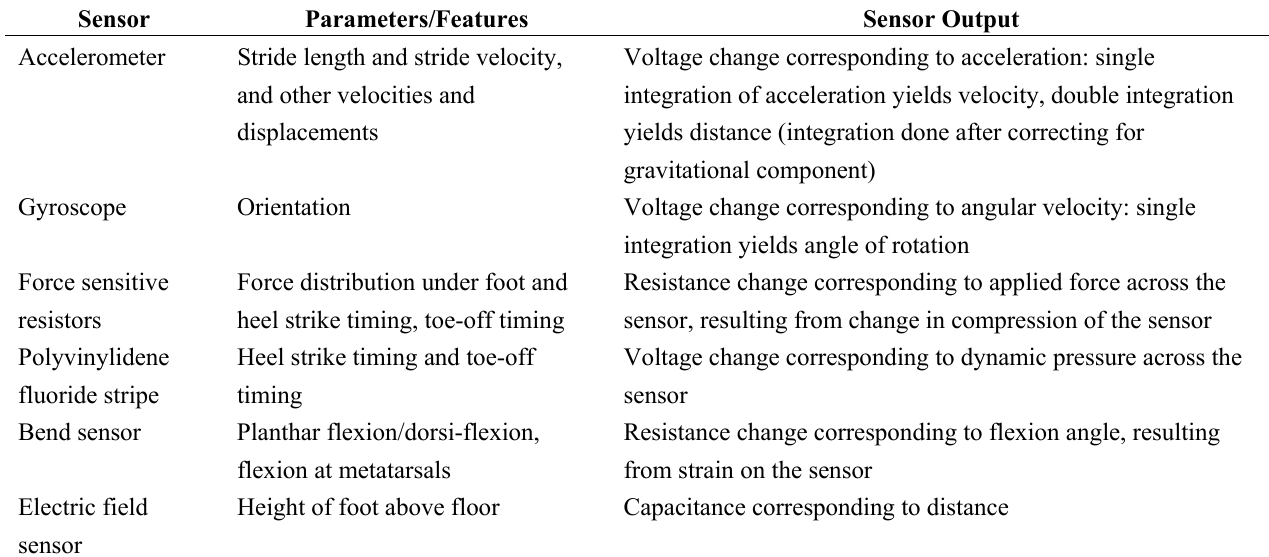
Table 11. Parameters/features extracted from the GaitShoe sensors